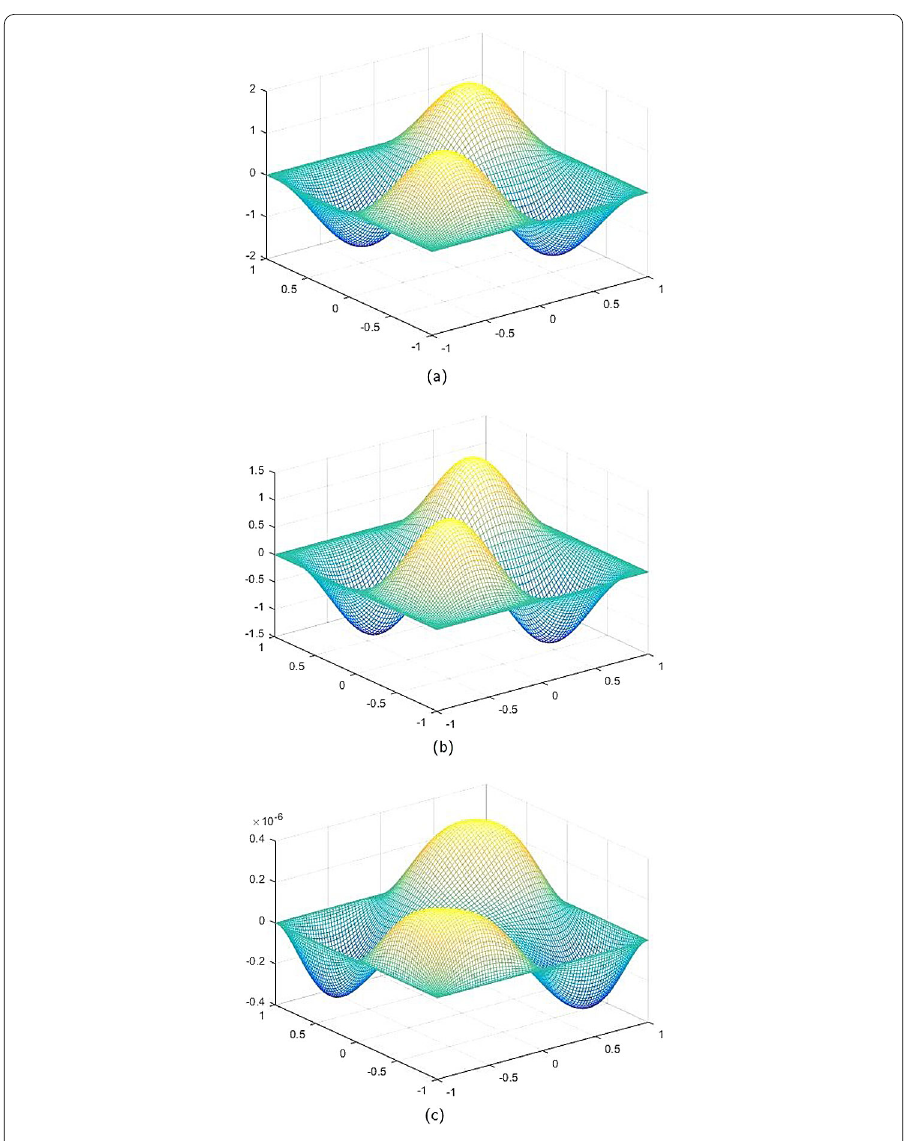
Figure 5 (a) The CNCS solution when t = 0.9. (b) The analytical solution when t = 0.9. (c) The errors between the analytical solution and CNCS solution at t =